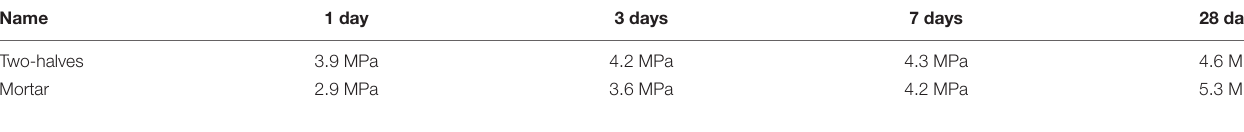
FIGURE 12 | ESEM images of (a) the fiber-matrix connection area and (b) the morphology of UHMWPE. TABLE 7 | Bonding strength results of two-halves and pure mortar specimens at the age of 1, 3, 7, and 28